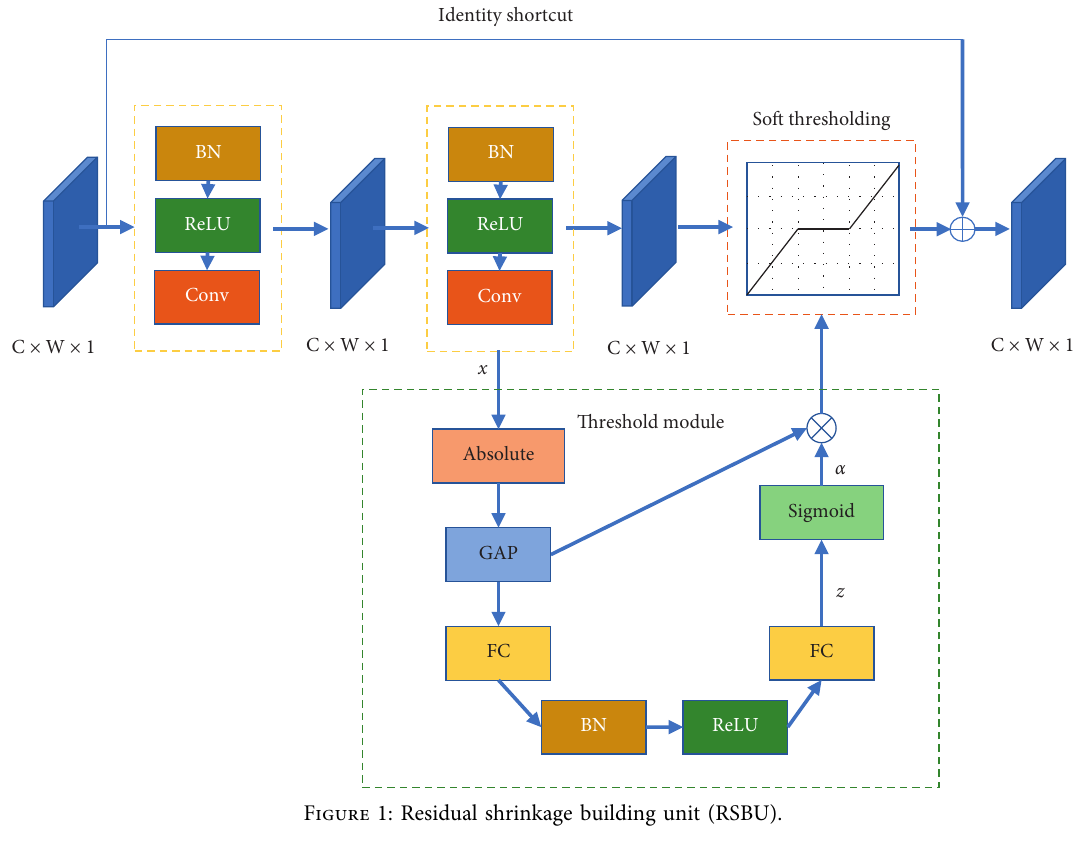
Figure 1: Residual shrinkage building unit (RSBU).